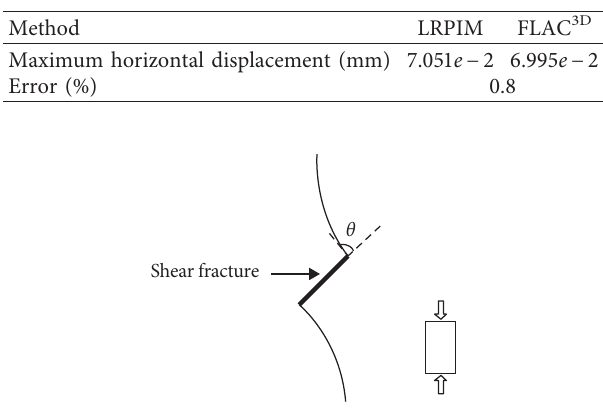
Figure 9: Crack propagation under uniaxial compression [26].